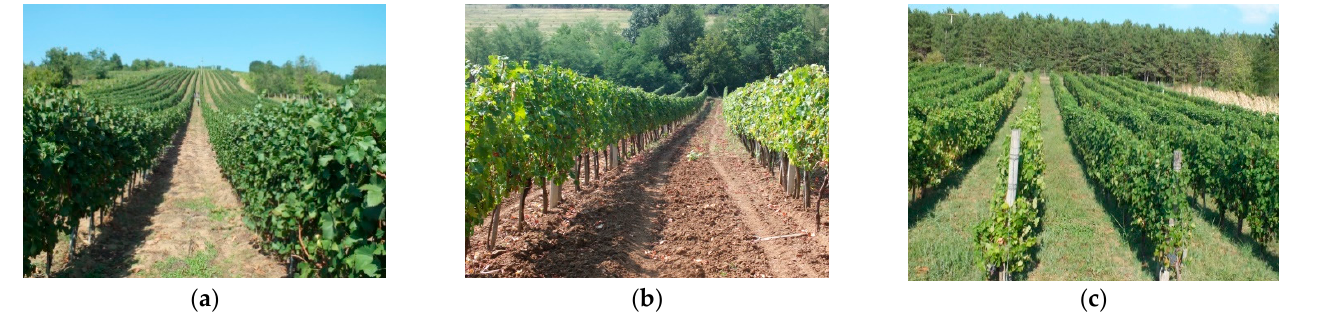
Figure 3. Some localities of observed vineyards: ( a ) Trstenik, ( b ) Baˇcina, ( c ) Glavica. Table 1. Locations, vine growing districts and soil types of the vineyards.